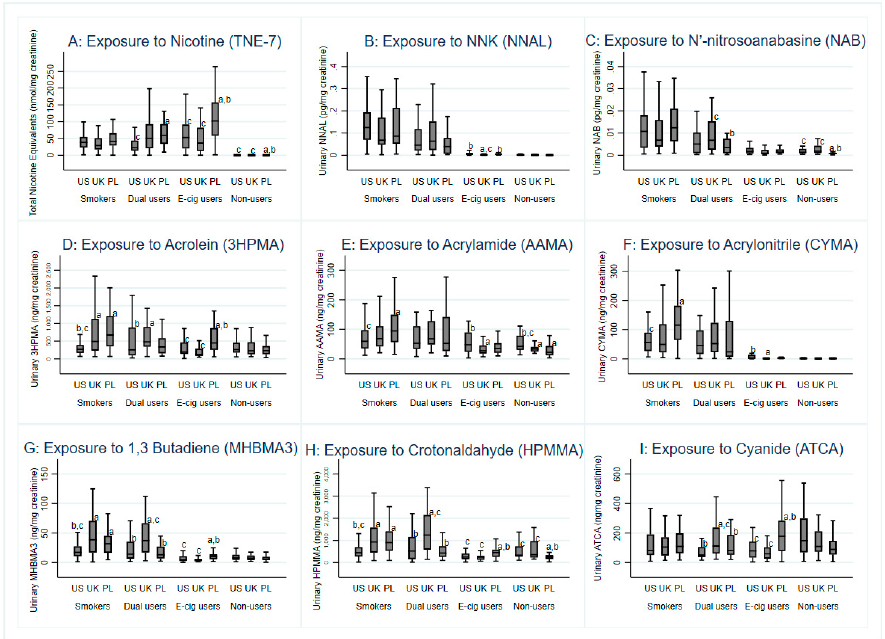
Figure 1. Biomarkers of exposure ( A ) nicotine, ( B ) tobacco-specific nitrosamine NNK, ( C ) N’-nitrosoanabasine, ( D ) acrolein, ( E ) acrylamide, ( F ) acrylonitrile, ( G ) 1,3-butadiene, ( H ) crotonaldehyde, and ( I ) cyanide; by tobacco use status and country of residence ( n = 456) . Superscript letters denote within-group differences by country of residence. a = significantly different from US; b = significantly different from UK; c = significantly different from Poland (PL) (according to sidak adjusted p -value < 0.05). Table 2. Biomarkers of exposure to nicotine and selected toxicants in urine of exclusive E-cigarette users ( n = 124) from US, UK and Poland (normalized for creatinine; geometric means, 95% confidence